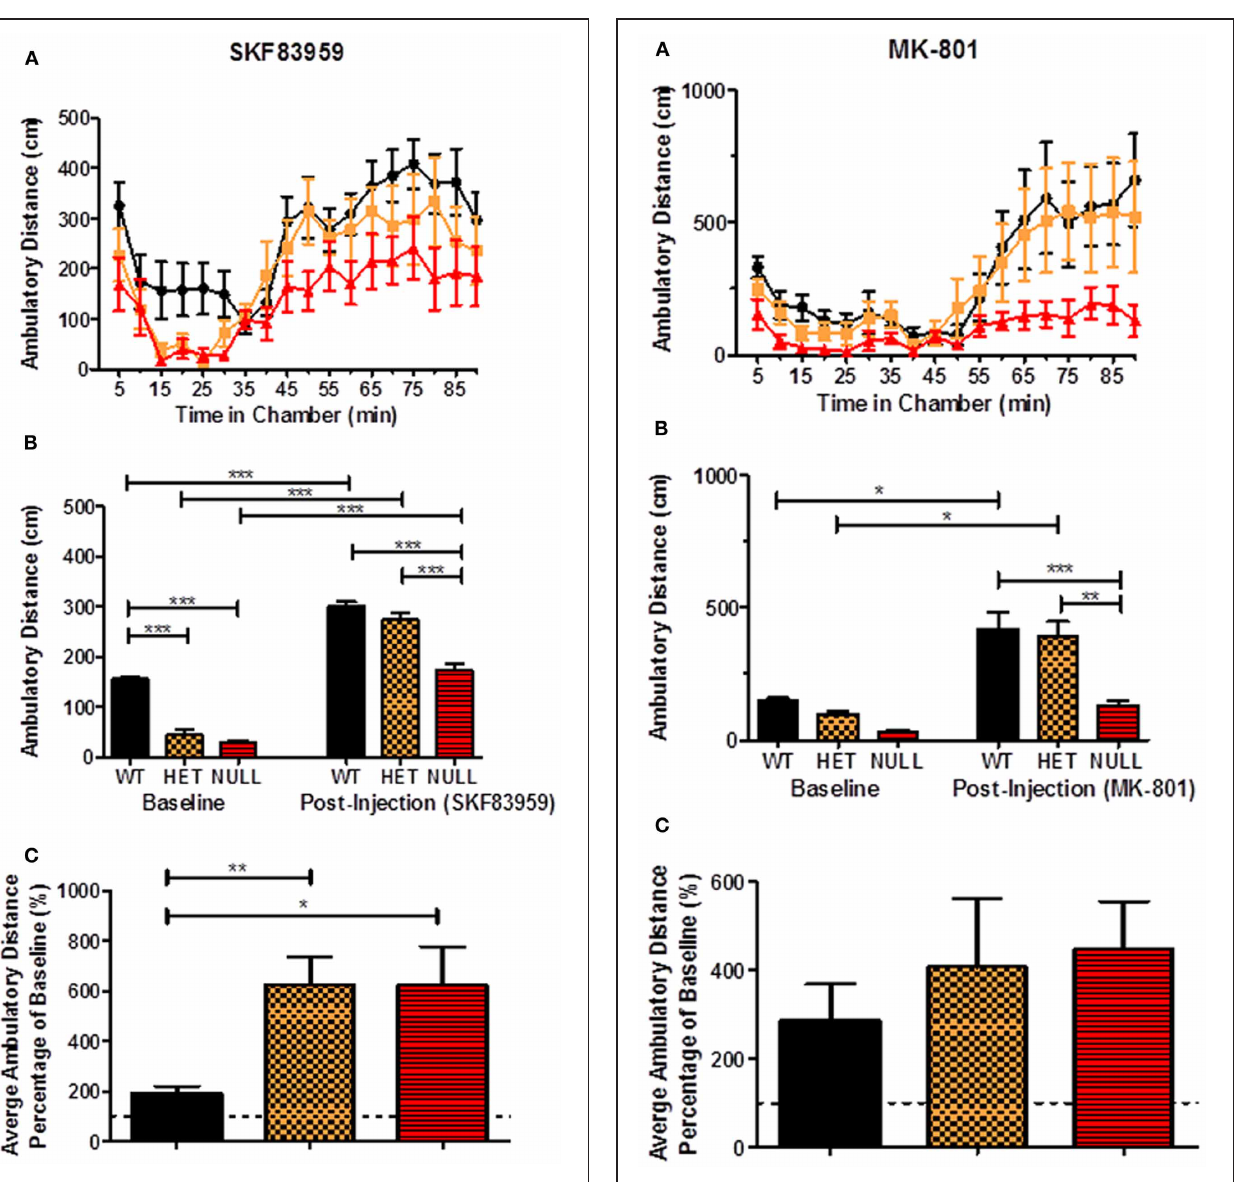
FIGURE 10 | Locomotor response to acute MK-801. The NMDA receptor antagonist MK-801 (0.2mg/kg; i.p.) induced a significant locomotor response in wildtype and heterozygous mice [ F ( 5 , 36 ) = 9 . 8, p < 0 . 05] but not in G α q knockouts (A,B) . Additionally, there were no significant changes observed in the percentage change from baseline between the genotypes (C) . n = 6–12 for each genotype in these